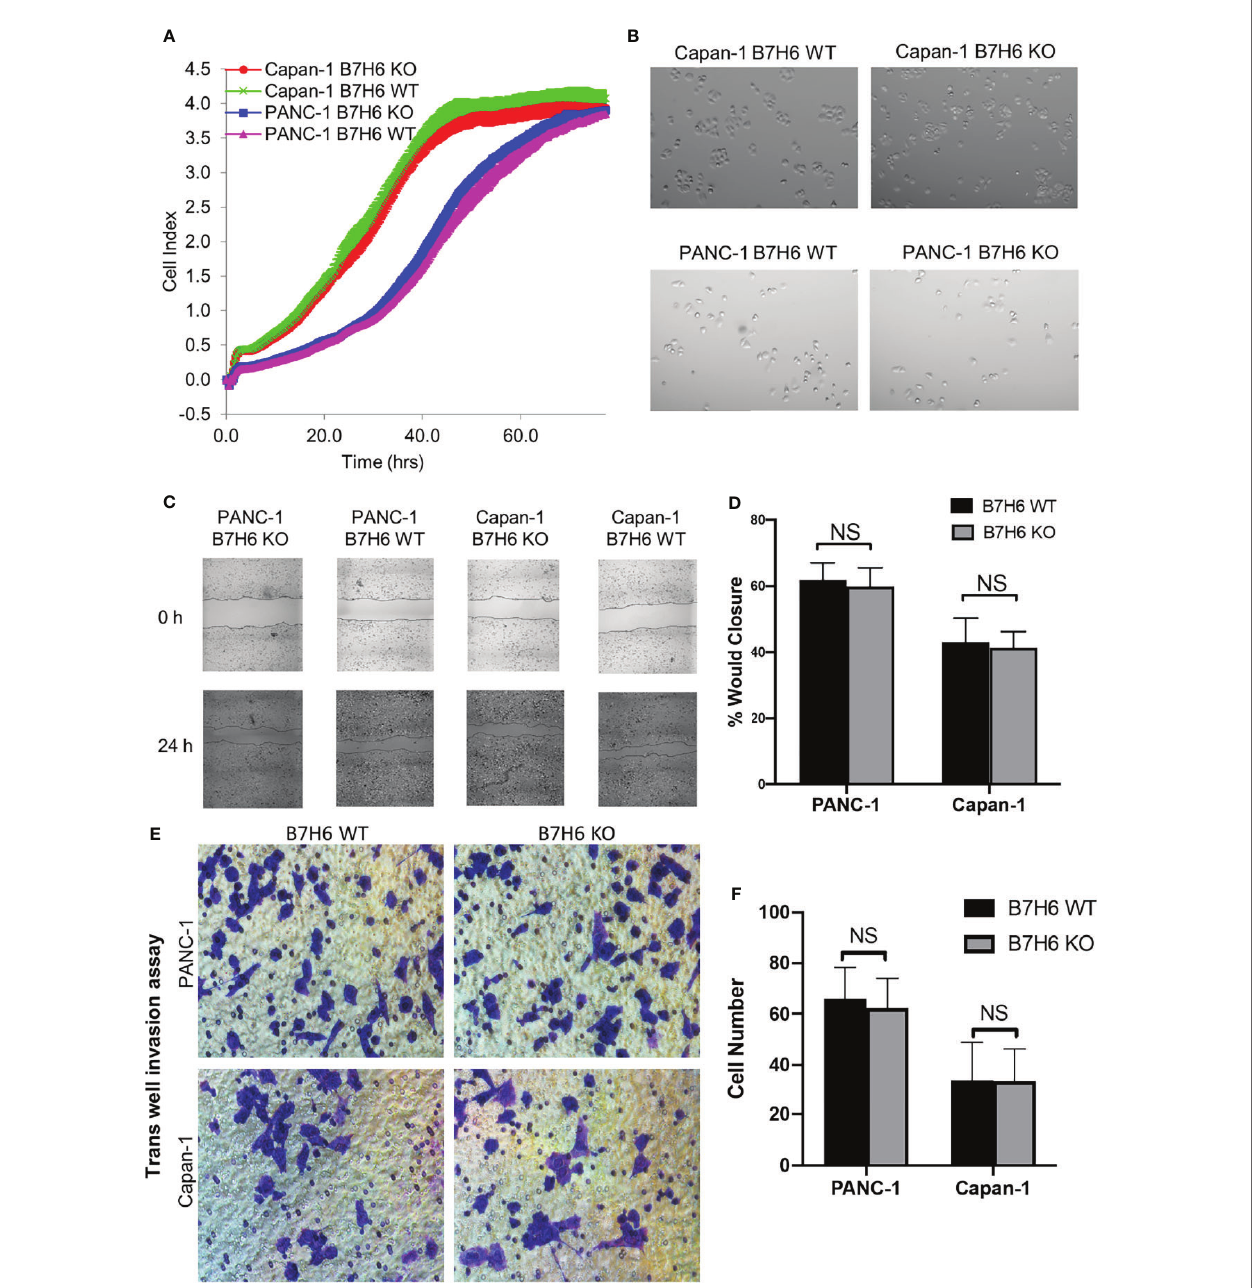
FIGURE 4 | Knocking down B7H6 does not affect cell survival, apoptosis, ormigration of pancreaticcancer cell lines. (A) RTCA analysis of proliferation of WTand B7H6 KOPC cells. The x-axisshows the timeof theassay.The y-axis represents growth (fold change) of the indicated cells. (B) Cellmorphology images of WTor B7H6 KOPC cells under a microscopeat 100x magni fi cation. (C) Representative image froma wound healing assay performed with B7H6 WTand KOofPANC-1 orCapan-1 cells. (D) The wound healingassay was quanti fi edusing ImageJ. (E) Transwellinvasion assay ofB7H6 WTand KOof PANC-1 and Capan-1 cells (magni fi cation 200×). (F) Quanti fi cation of invaded cells from the Transwellassay. Data from at least 3 independent experiments are shownas mean ± SEM. NS, not signi fi